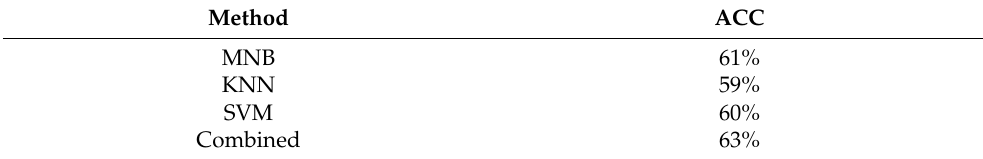
Table 3. Accuracy of respondent